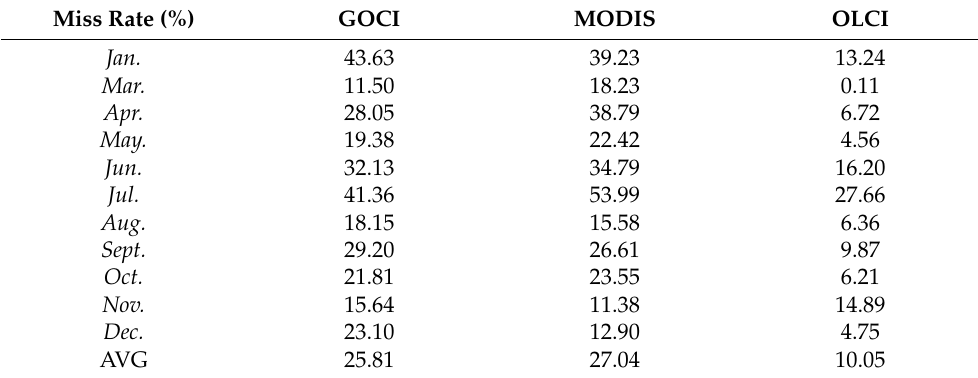
Table 5. Month-by-month missing rate of the three products. Miss Rate (%) GOCI